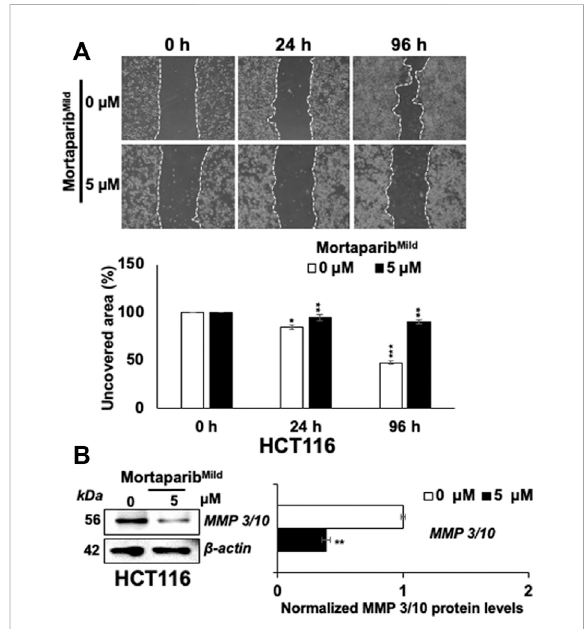
FIGURE 6 Mortaparib Mild caused inhibition of cell migration in HCT116 cells. (A) Mortaparib Mild (5 μ M)-treated cells showed delay in migration in Scratch-wound assays. (B) Treated cells showed decrease in MMP 3/10 expression on Western blots wherein β -actin was used as an internal loading control. Each data set represented the mean ± SD of at least three independent experiments. Statistical signi fi cance was de fi ned as values of p > 0.05 (ns), p ≤ 0.05 (*), p ≤ 0.01 (**), p ≤ 0.001 (***), and p ≤ 0.0001 (****),whichrepresentnon-signi fi cant,signi fi cant,verysigni fi cant, highly signi fi cant, and extremely signi fi cant,